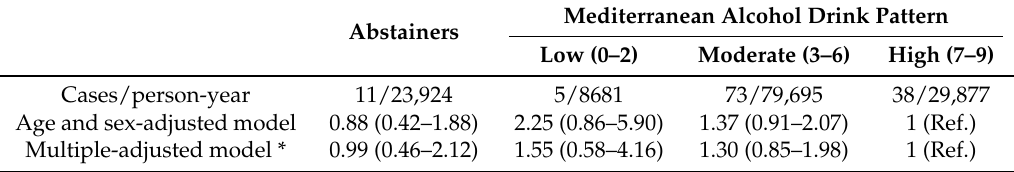
Table 2. Hazard ratios and 95% confidence intervals of incident cardiovascular events according to the categories of adherence to the Mediterranean alcohol-drinking pattern. The Seguimiento Universidad de Navarra (University of Navarra follow-up) (SUN) project (1999–2014). Abstainers